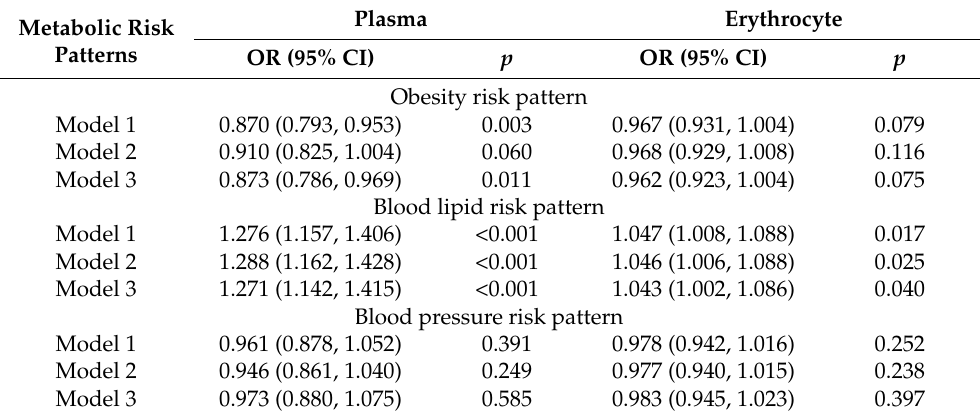
Table 6. The association of metabolic risk patterns with plasma and erythtocyte DHA status by multivariate logistic regression